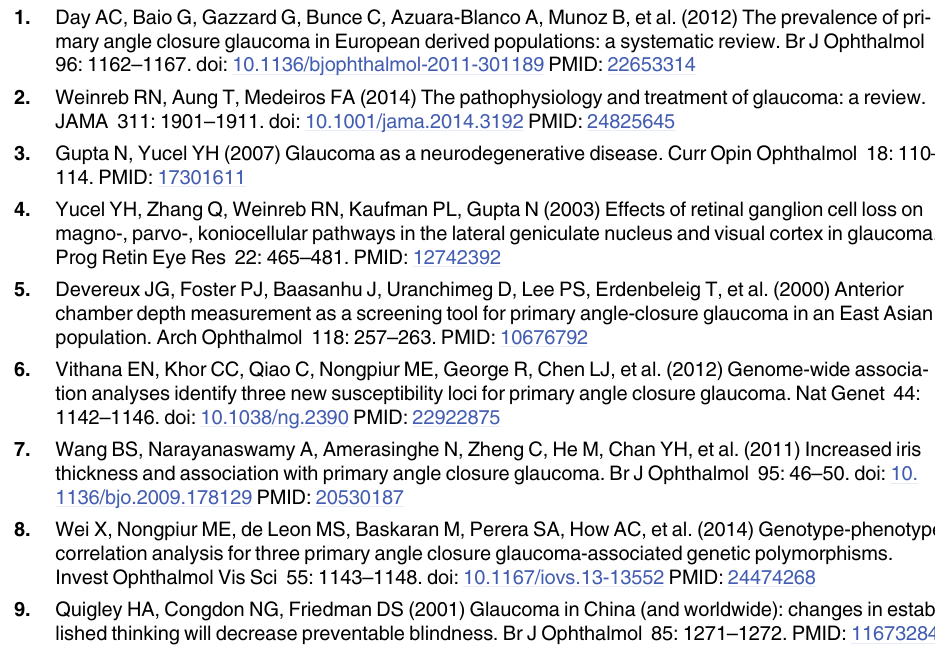
brain areas of DC between Pre-PACG v . s . Controls and Post- v . s . Pre-PACG, respectively. Cool color (blue) indicates the decreased DC areas and the hot color (red) indicates the opposite. Left in the figure indicates the left side of the brain. (TIF) S2 Fig. Voxel-wise comparison of DC between Pre-PACG v . s . Controls and Post- v . s . Pre- PACG patients with different thresholds. The four boxes demonstrate the results with differ- ent thresholds ( r = 0.15, 0.20, 0.30 and 0.35) respectively. Row (a) and (b) in each box shows the different brain areas of DC between Pre-PACG v . s . Controls and Post- v . s . Pre-PACG, respectively. Cool color (blue) indicates the decreased DC areas and the hot color (red) indi- cates the opposite. Left in the figure indicates the left side of the brain. And the results in the paper are not influenced with different